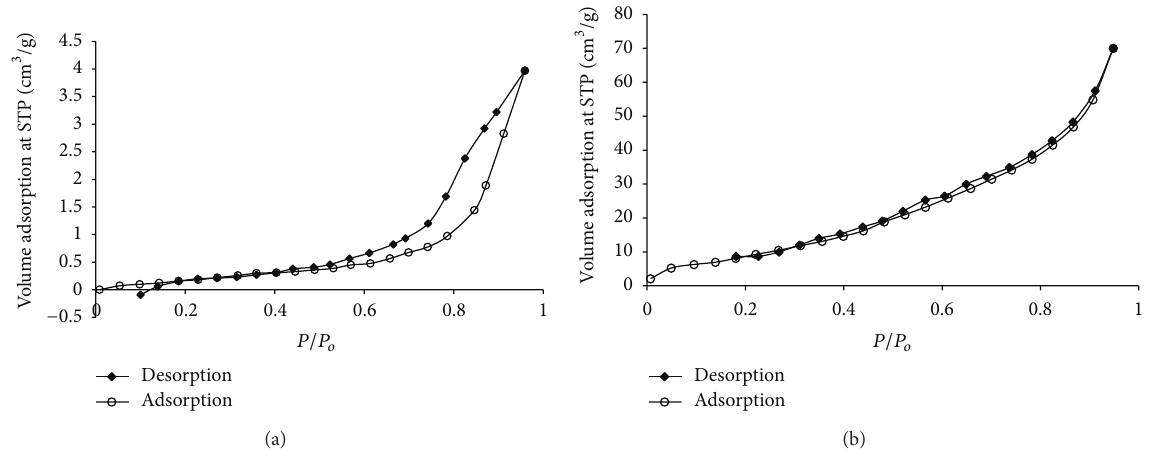
Figure 6: N 2 adsorption-desorption isotherm of calcined MS at 800 ∘ C (a) and CS at 700 ∘ C.